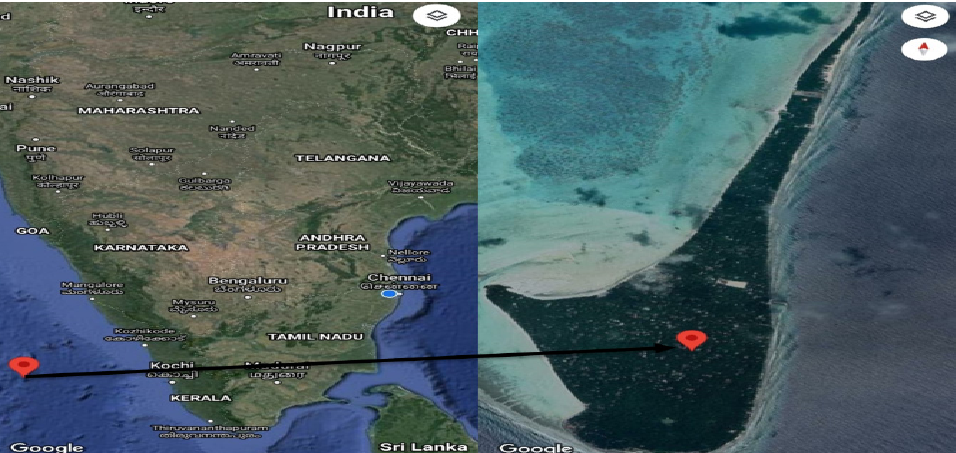
Figure 1. Location of Kalpeni Island, India (satellite view).